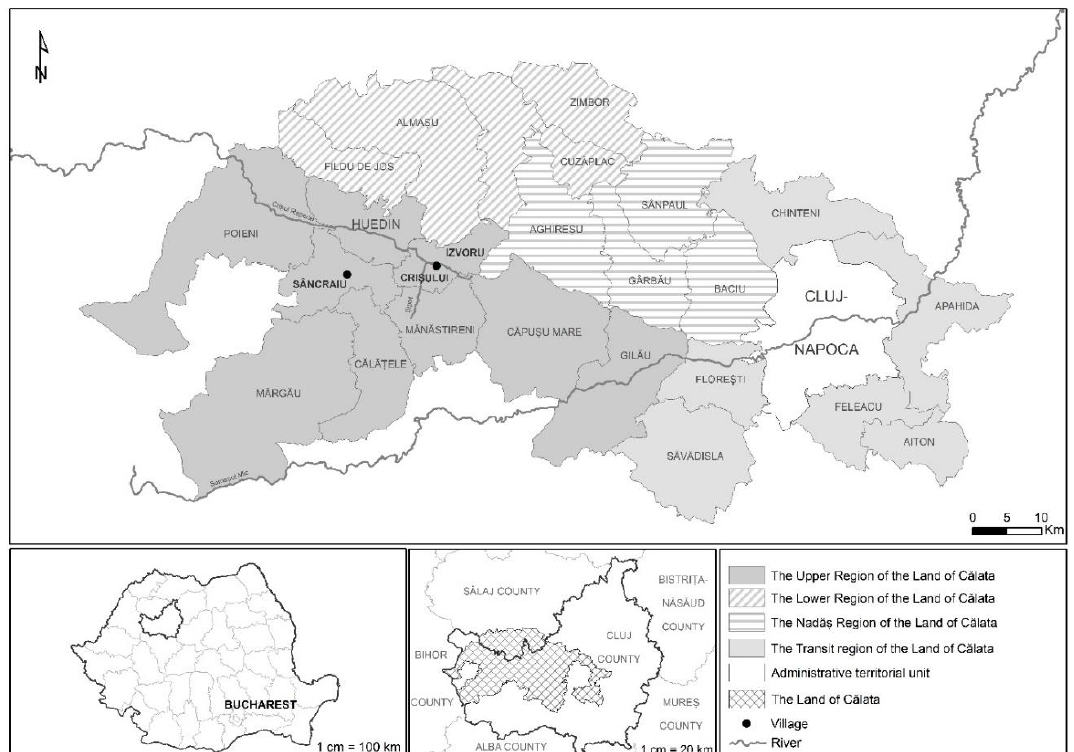
Figure 1: The Land of Călata (after Filip and Matiș, 2014) Cartography by Roxana-Maria